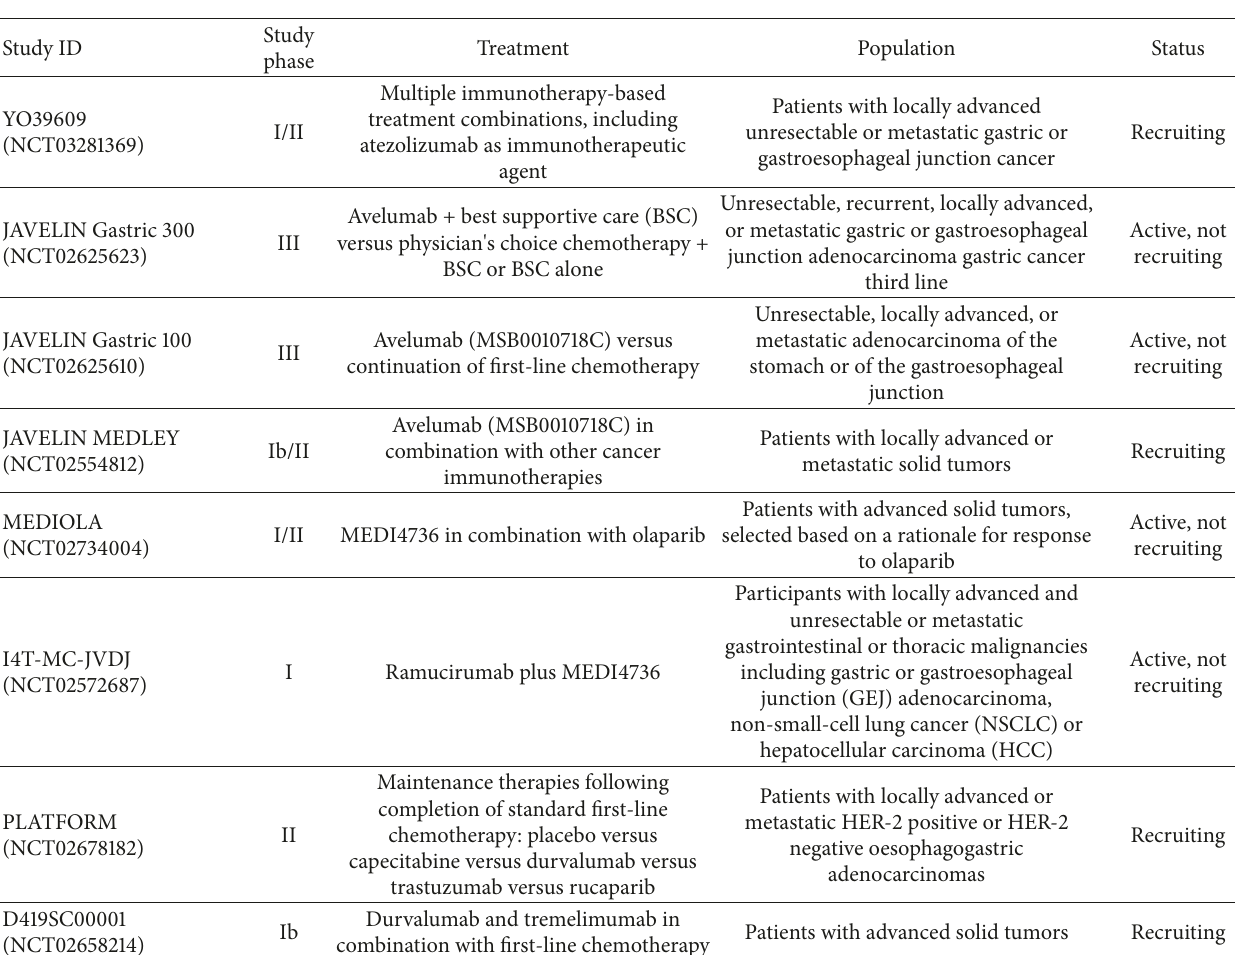
Table 2: Ongoing trials with anti-PD-L1 in advanced gastric